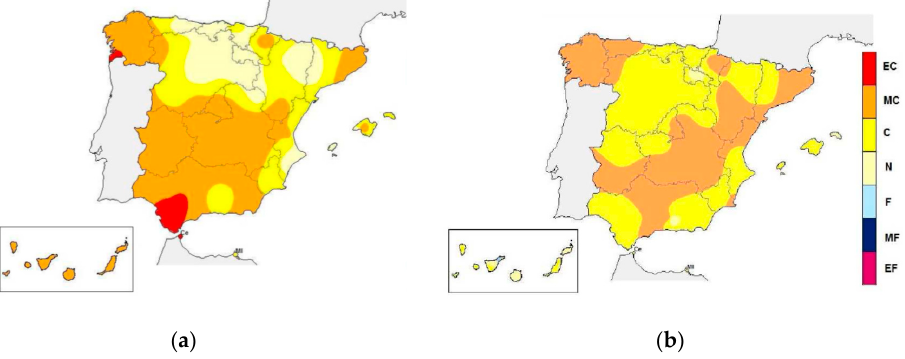
Figure 14. On the ( a ) is shown the August 2013 temperatures in Spain [43], on the ( b ) are the September 2013 temperatures [42]. Note that Seville is affected by unusually hot temperatures during the first days of august.